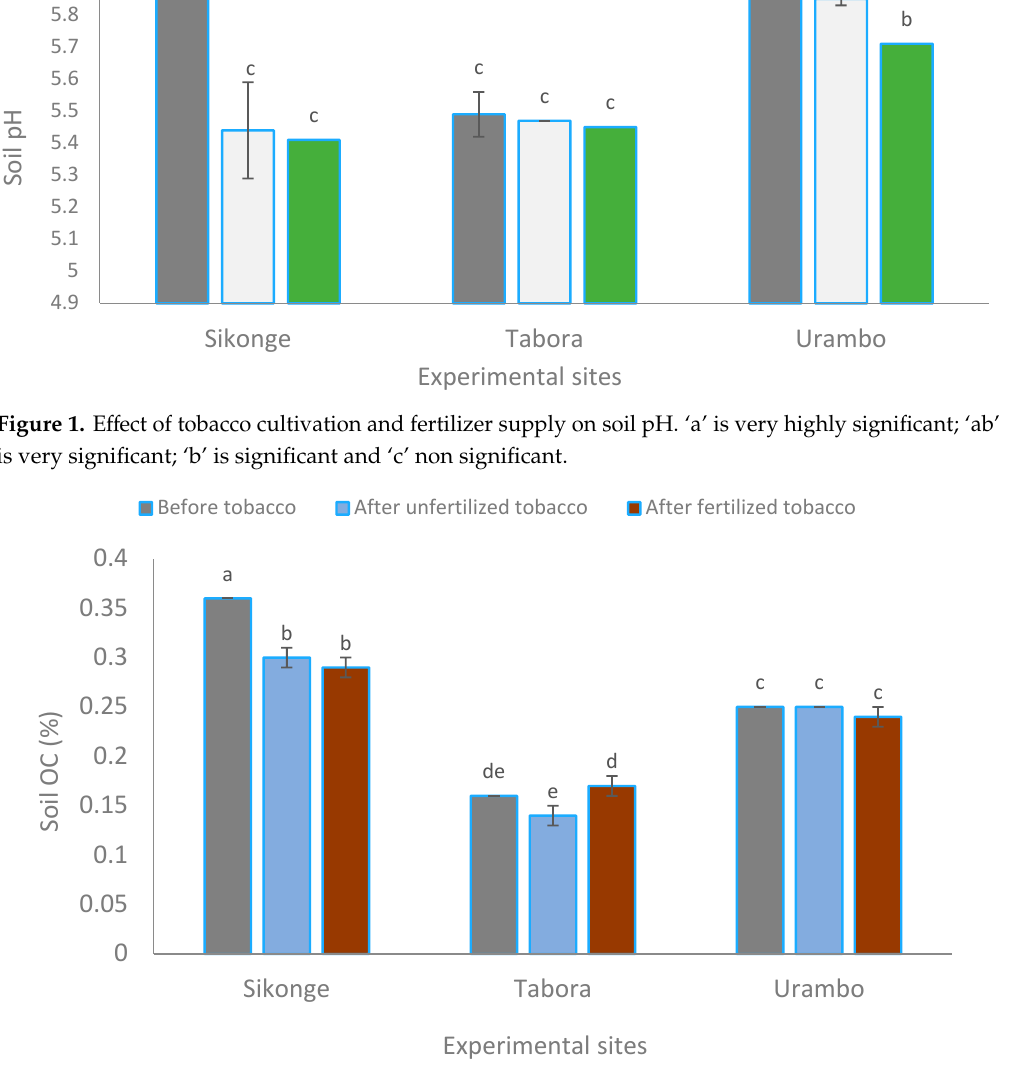
Figure 2. Effect of tobacco cultivation and fertilizer supply on soil organic carbon (OC). ‘a’ is very highly significant; ‘b’ is highly significant; ‘c’ & ‘d’ are significant; ‘e’ non significant